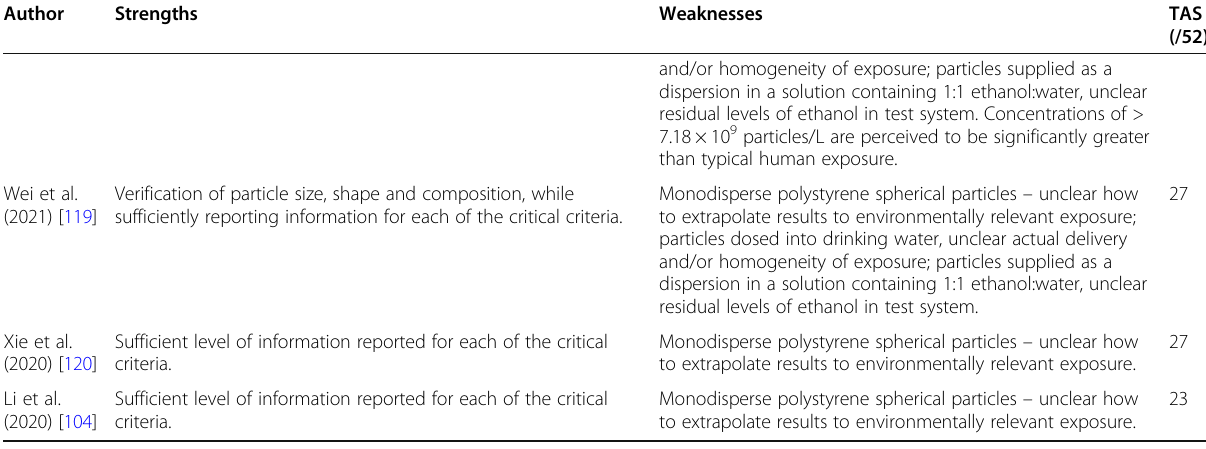
Table 1 Summary of total assessment scores (TAS) and QA/QC criteria strengths and weaknesses of in vivo studies prioritized based on adequate evaluation of critical QA/QC identified as part of a Tier 1 screening assessment. Strengths and weaknesses listed reflect how the data support or limit, respectively, the interpretation of study results within a risk assessment context. Strengths and weaknesses are thus context-specific, and those listed as strengths here may be perceived as weaknesses under another context, and vice versa. Additional study information included in the Supplementary Information